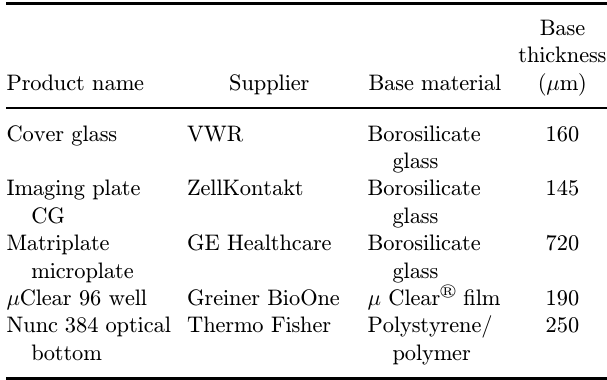
Table 1. Sample holder parameters.